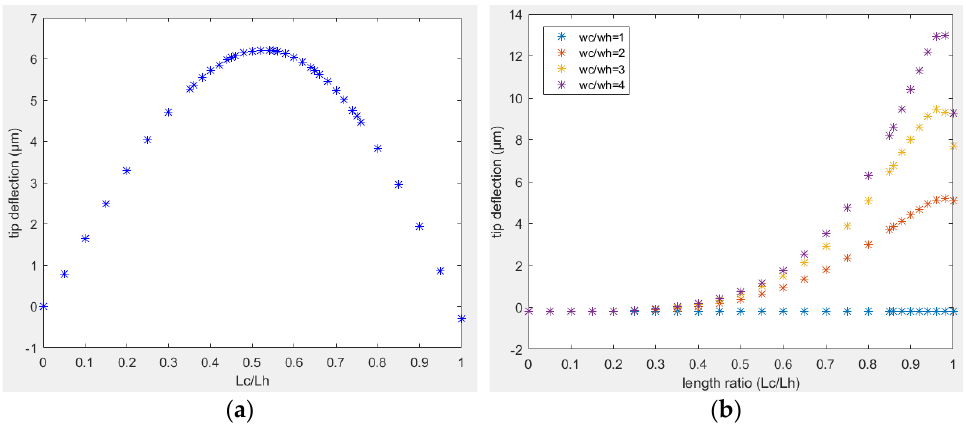
Figure 11. Tip deflection in function of length ratio between two arms: ( a ) design A; ( b ) design